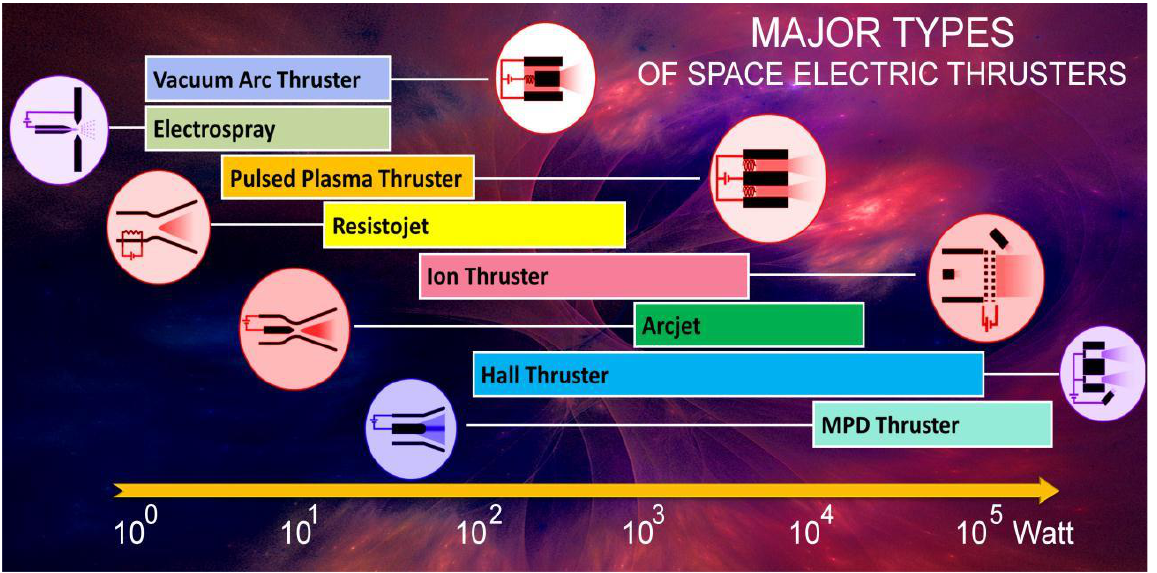
Figure 1. The major types of space electric propulsion thrusters spanning the input power to the thruster. The circled icons represent the basic electrical schematics of each type of thruster. This image illustrates the wide spread of physical complexity that is manifested by the numerous propulsion devices employed over five orders of magnitude of power to the thruster.